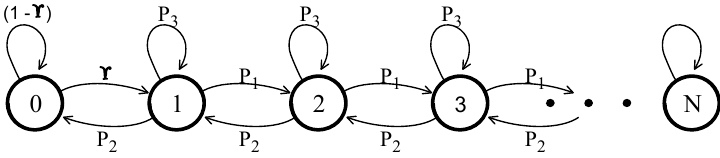
Figure 6. Birth and death Markov